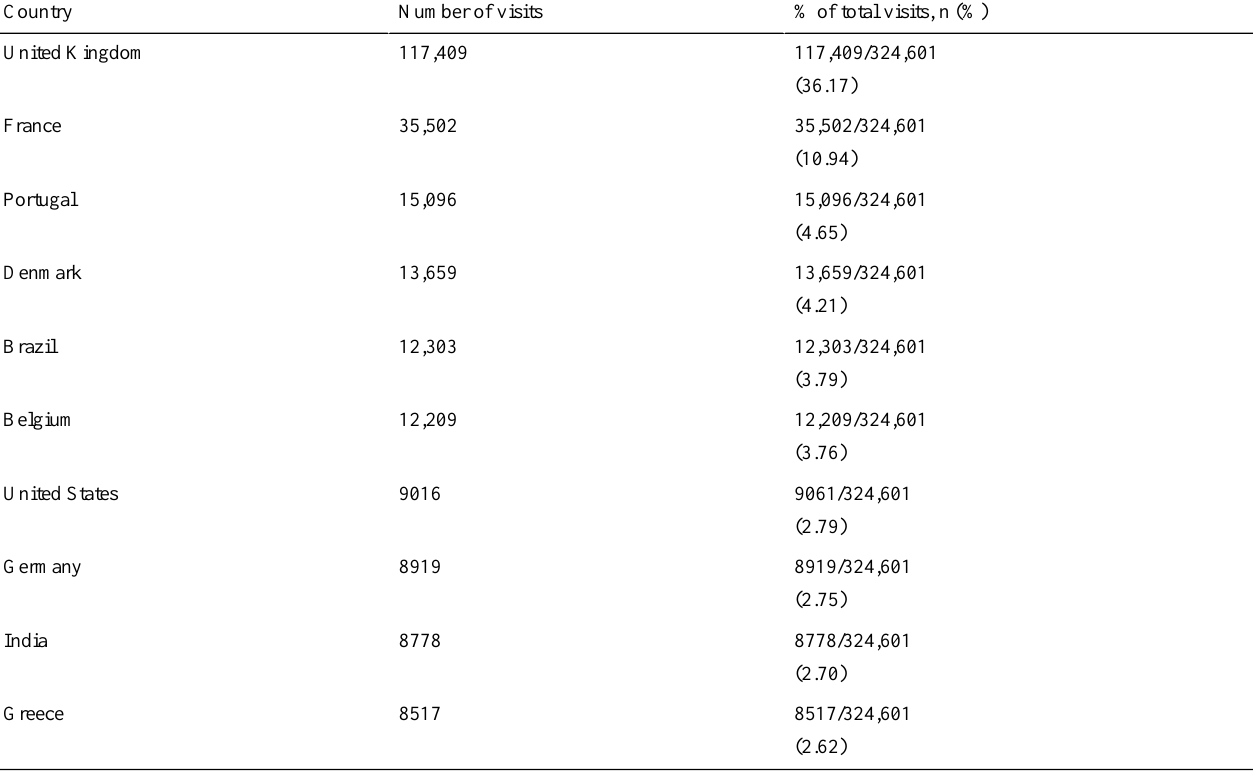
Table 2. Top 10 countries visiting the e-Bug website between September 2010 and August 2013.